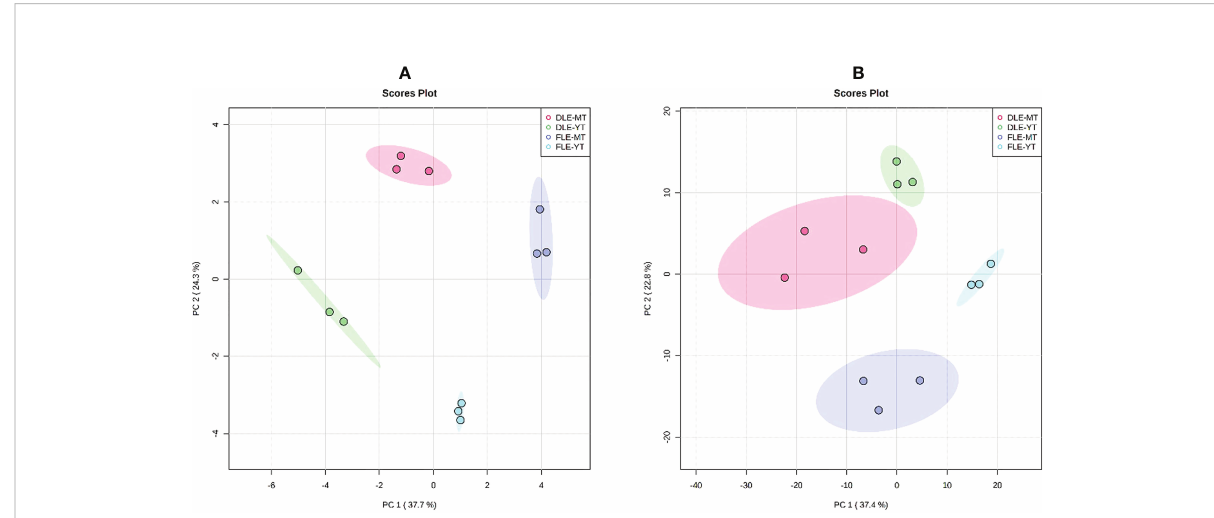
FIGURE 2 Principal component analysis (PCA) plots based on the results of (A) GC-MS and (B) HPLC-MS analysis of the 4 groups of samples: the aqueous extracts prepared with dried leaves of mature E globulus trees (DLE-MT; red); the aqueous extracts prepared with fresh leaves of mature E globulus trees (FLE-MT; purple); the aqueous extracts prepared with dried leaves of young E globulus trees (DLE-YT; green); and the aqueous extracts prepared with fresh leaves of young E globulus trees (FLE-YT; blue). Scree plots are shown in Figure